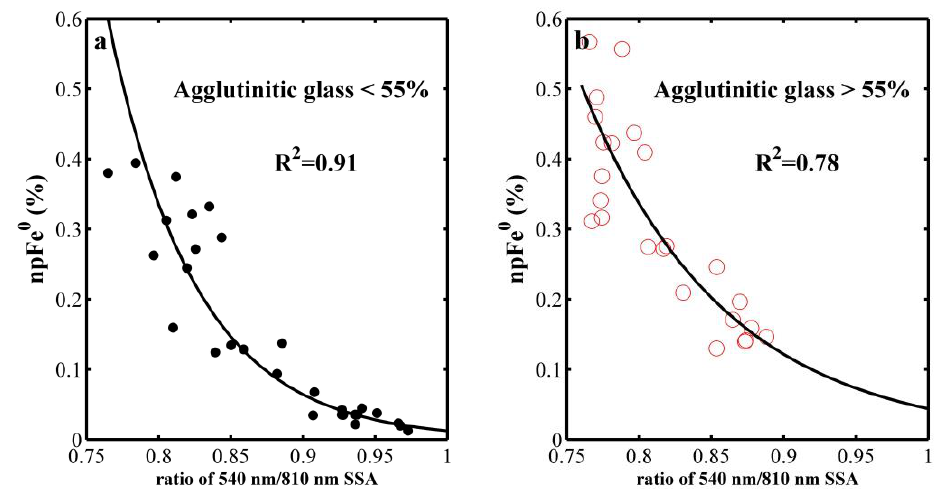
Figure 11. Correlation between the ratio of 540 nm SSA / 810 nm SSA and npFe 0 for ( a ) lunar soil samples with agglutinitic glass content < 55% and for ( b ) lunar soil samples with agglutinitic glass content > 55%.